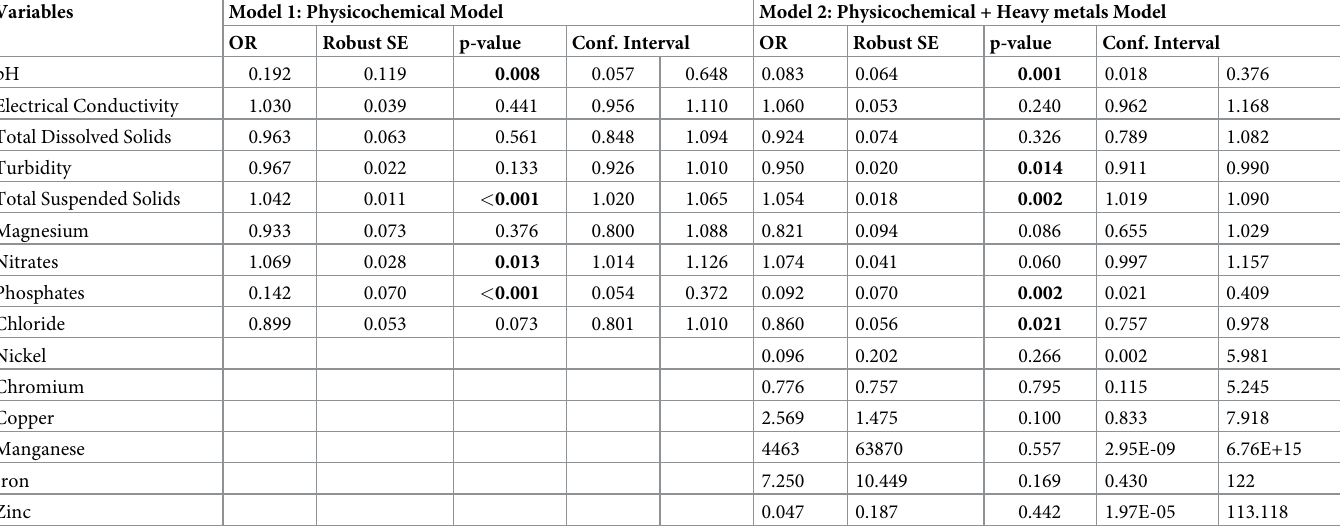
Table 8. Multivariate negative log–log regression model predicting detection of total coliform in ground water. Variables Model 1: Physicochemical